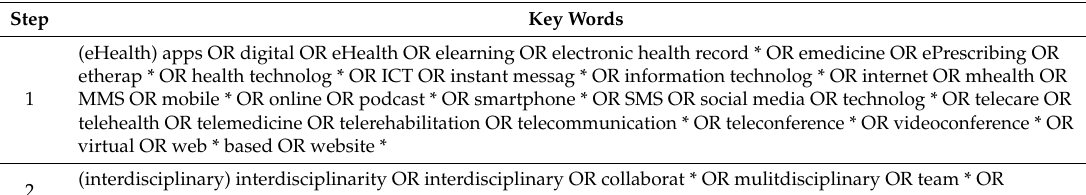
Table 1. Example of the search strategy implemented into